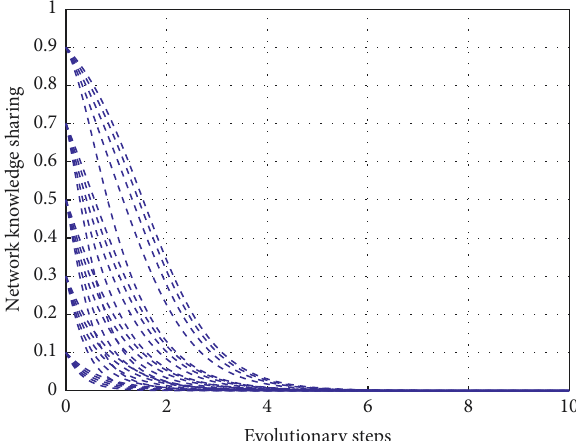
Figure 9: Evolutionary game path of network knowledge sharing.